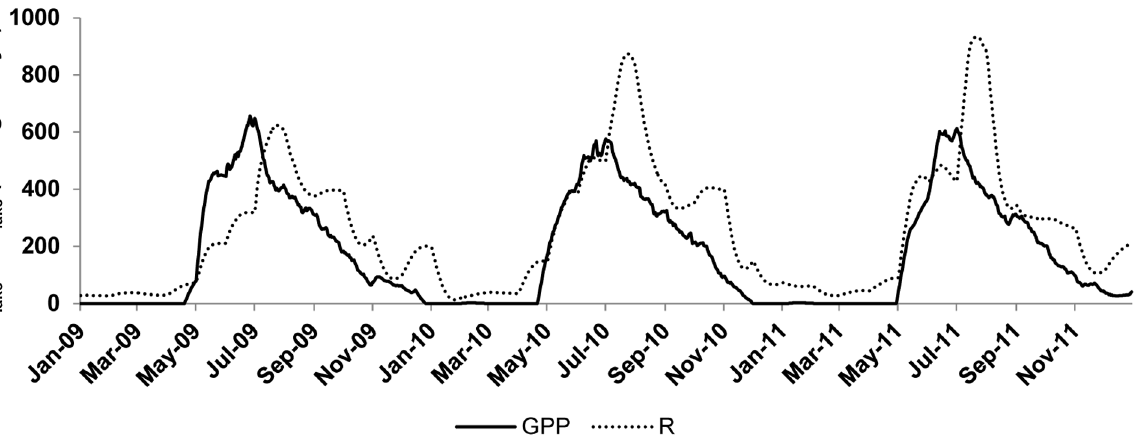
Figure 2. Dynamics of GPP lake and R lake during the 2009–2011 period calculated with ecosystem approach. Both parameters are expressed in 10 3 kg C day 2 1 .